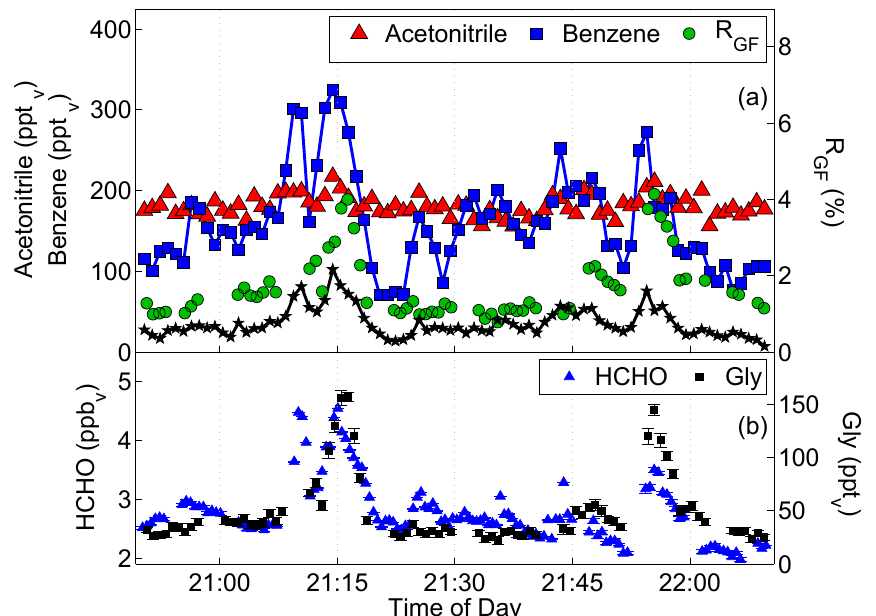
Fig. 6. A closer view of sharp changes in (a) benzene, acetonitrile, and C 6 H 7 O + concentrations and R GF and (b) HCHO and Gly during day BN3 (DOY 226). C 6 H 7 O + is attributed to phenol and is expressed in arbitrary units (AU). Data is shown at maximum resolution, and no binning was employed. The evening event shown is the only instance during HCHO and Gly measurement of greater than 0.65 AU C 6 H 7 O + , which was typically less than 0.2 AU. Error bars are shown for HCHO and Gly, denoting 1 σ precision.